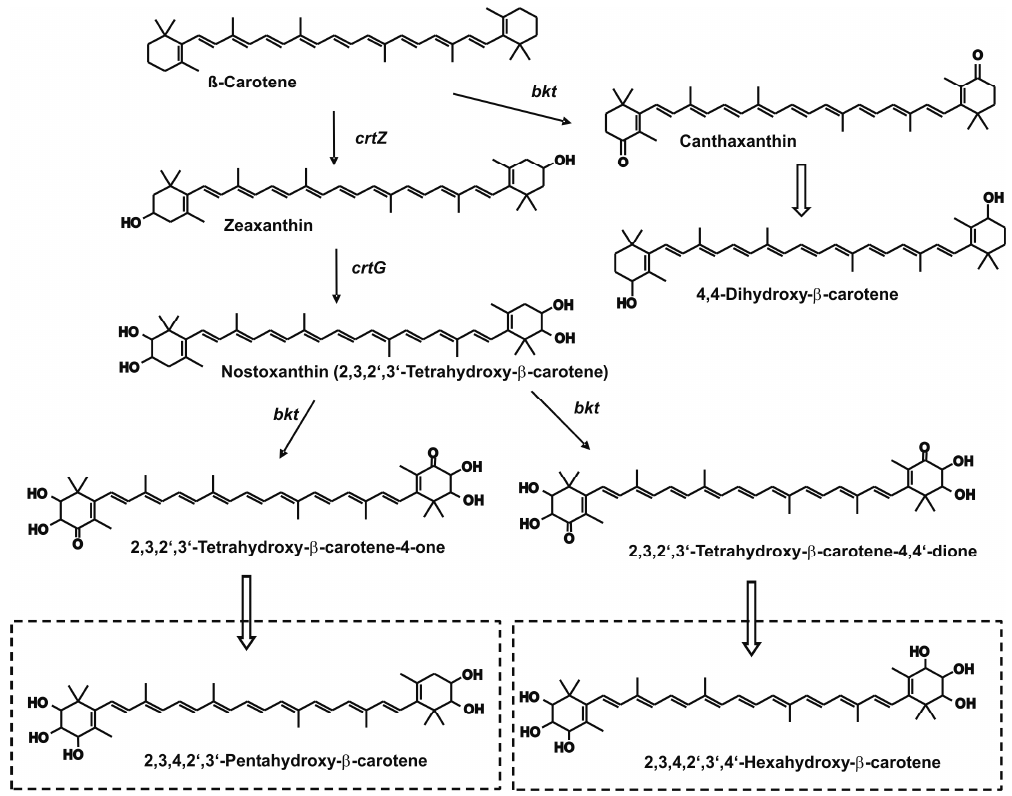
Figure 1. Pathway construction by genetic engineering of Xanthophyllomyces dendrorhous for the synthesis of multi-oxygenated β -carotene derivatives. Open arrows indicate chemical reduction. Novel carotenoid structures are boxed.